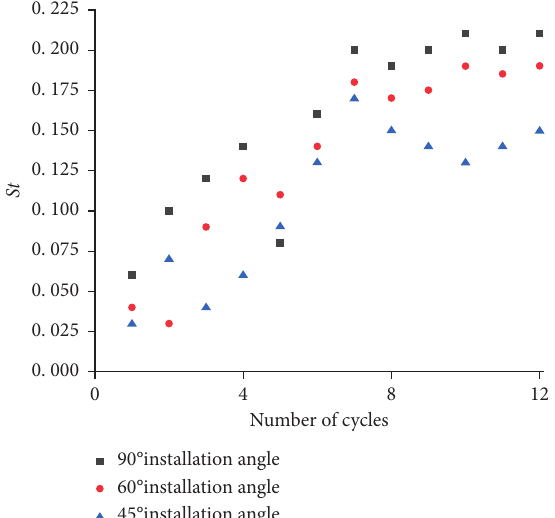
Figure 14: Variation of Strouhal number at thermowell different installation angles.